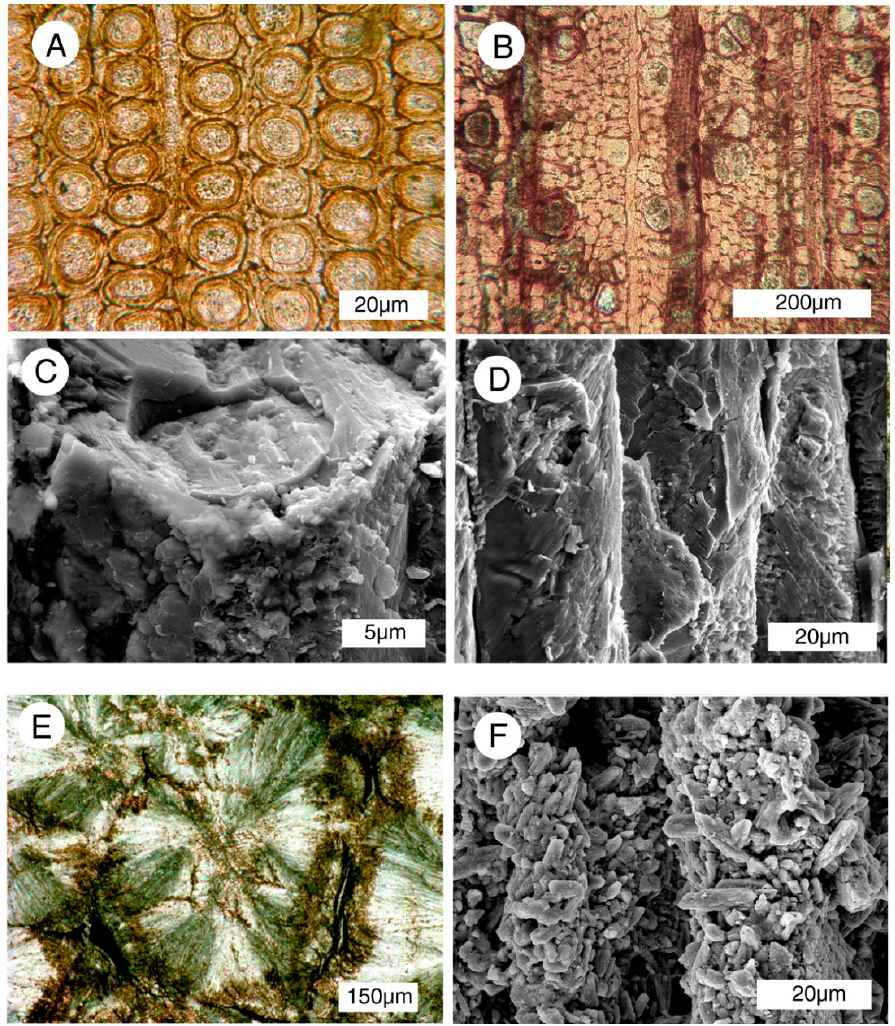
Figure 8. Calcite-mineralized woods showing weak or no evidence of permineralization. ( A – E ) are from the Cretaceous Nanaimo Group, Vancouver Island, BC, Canada. ( A ) Specimen from Puntledge River, transverse orientation. Relict organic matter is present as very thin cell borders; ( B ) Specimen from Collishaw Point, Hornby Island, transverse orientation. Relict organic matter causes thin walls to be brownish red; ( C ) SEM view of a single tracheid of Puntledge River wood. Cell wall appears thick because of microcrystalline calcite. Lumen is filled with more coarsely crystalline calcite; ( D ) SEM view, specimen from Port Moody, tangential orientation. Relict smooth surfaces of cell walls are mineralized with calcite; ( E ) Port Hardy specimen, transverse orientation. Polarized light illumination shows radiating calcite crystals that have disrupted cellular tissue; preserve smooth texture; ( F ) Neogene wood from Glades County, FL, USA. Tangential orientation, showing tracheid walls mineralized with coarsely-crystalline calcite.